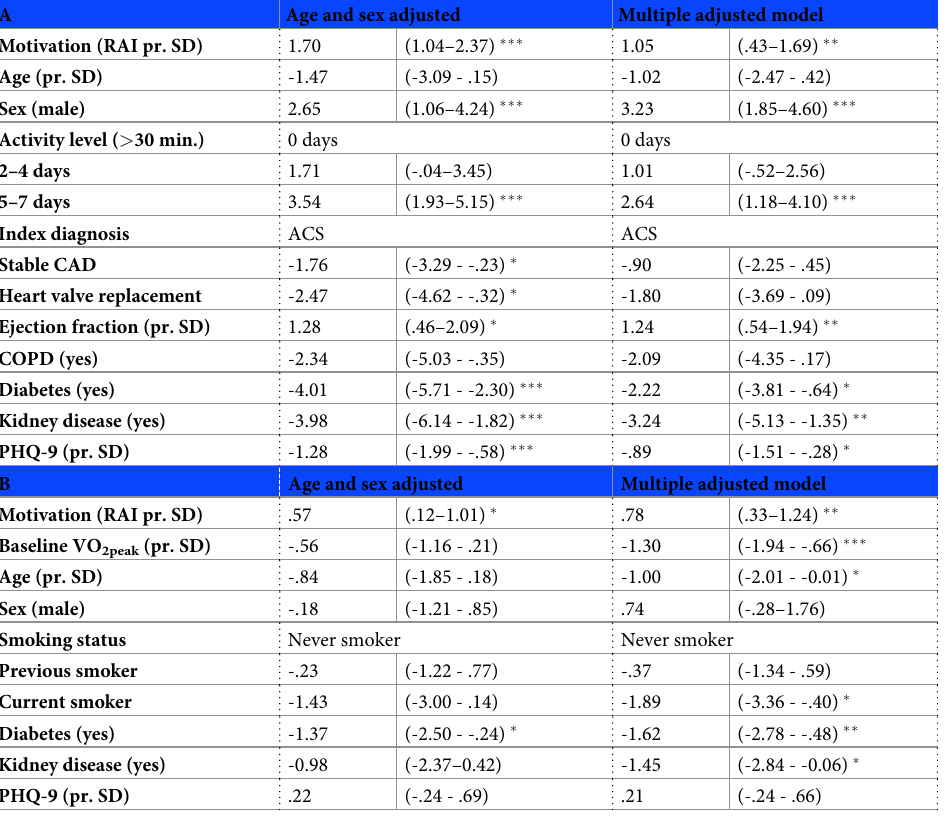
Table 2. Standardized coefficients of predictors of VO 2peak before cardiac rehabilitation (A) and a change in VO 2peak following cardiac rehabilitation (B). Values indicate the difference in